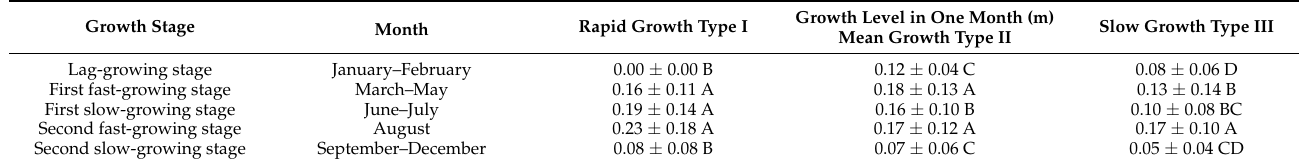
Figure 2. Monthly dynamics of growth traits for three types of C. axillaris families. ( A ): Monthly dynamics of height growth; ( B ): monthly dynamics of DBH growth; ( C ): monthly dynamics of crown width in row; ( D ): monthly dynamics of crown between rows. Table 5. Height growth stages for three types of C. axillaris